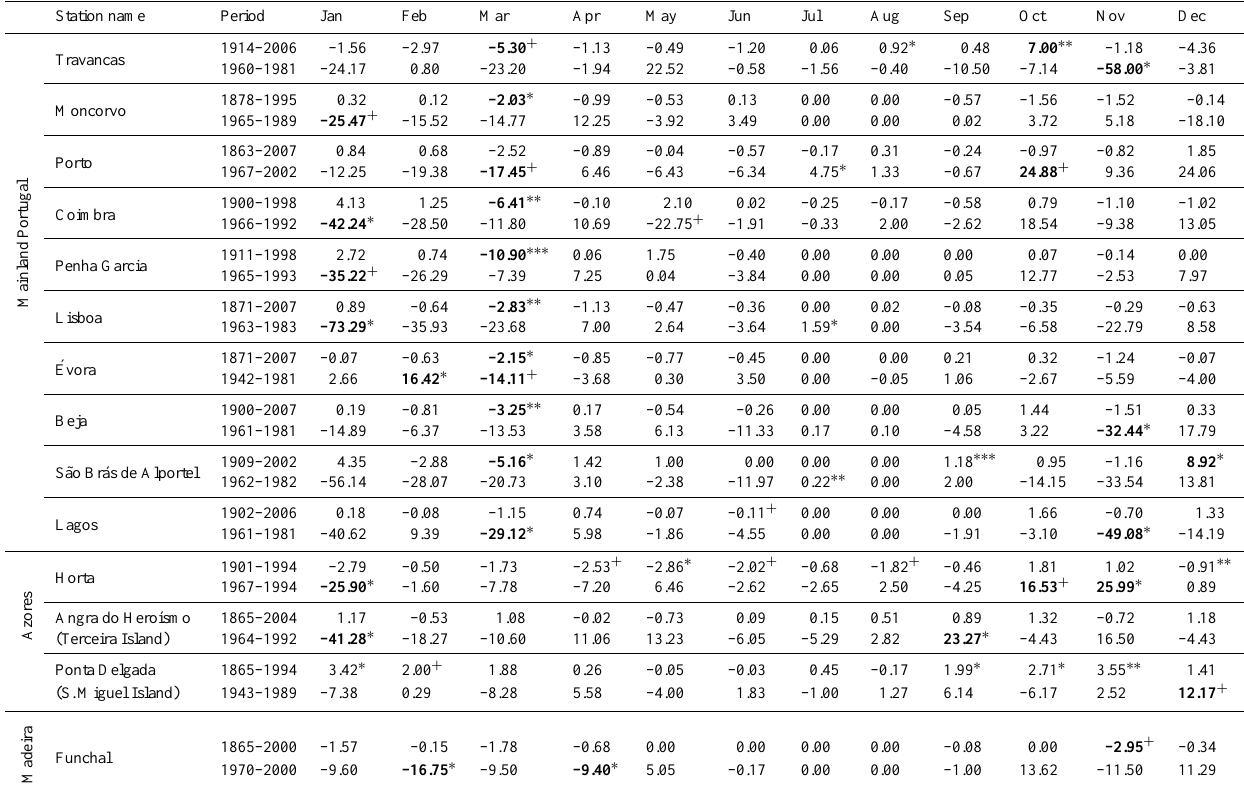
Table 4. Sen’s estimator of the monthly precipitation trends (mmdecade − 1 ) and the respective confidence levels: + 90%, ∗ 95%, ∗∗ 99% and ∗∗∗ 99.9%. The data are for the full period and for sub-periods of negative trend in annual precipitation, which were selected for each time series based on the breakpoints located in the partial trend analyses. The results for mainland Portugal were partly reported in de Lima et al.